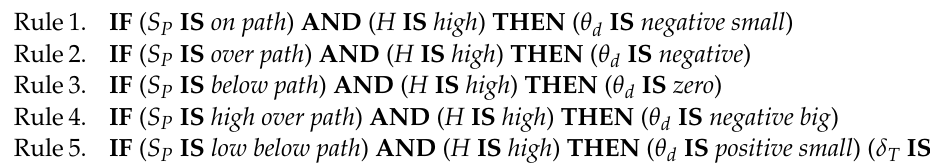
Figure 14. Phases of the landing and rule assignment.